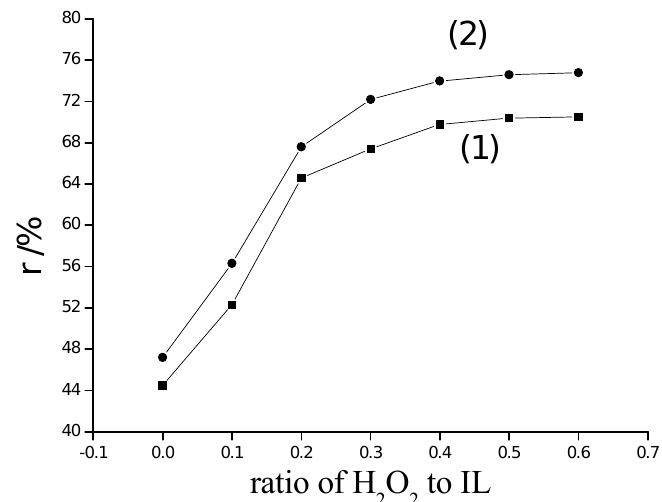
O on desulfurization in model oil. 2 2